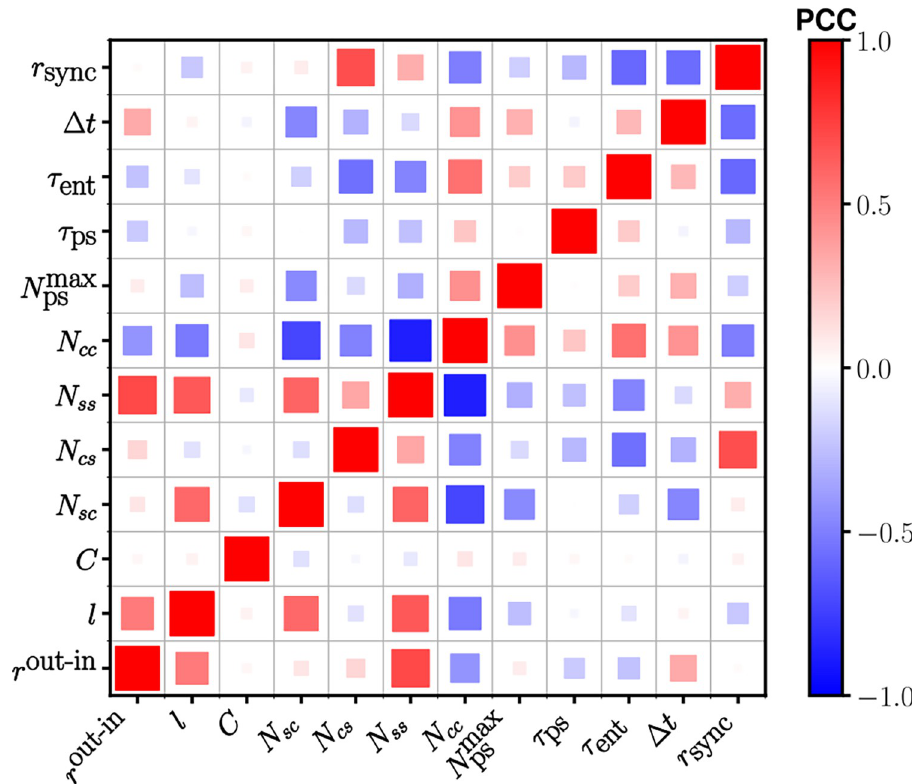
Fig 8. Pairwise Pearson correlation (PPC) map of various network morphological properties and measures characterizing the dynamical aspects of the chosen 482 model SCNs. The number of edges within the core ( N cc ), ), from the core to the shell ( N ), and from the shell to the core ( N ) are compared with several within the shell ( N ss cs sc different measures related to the circadian phase dynamics within the model SCN.